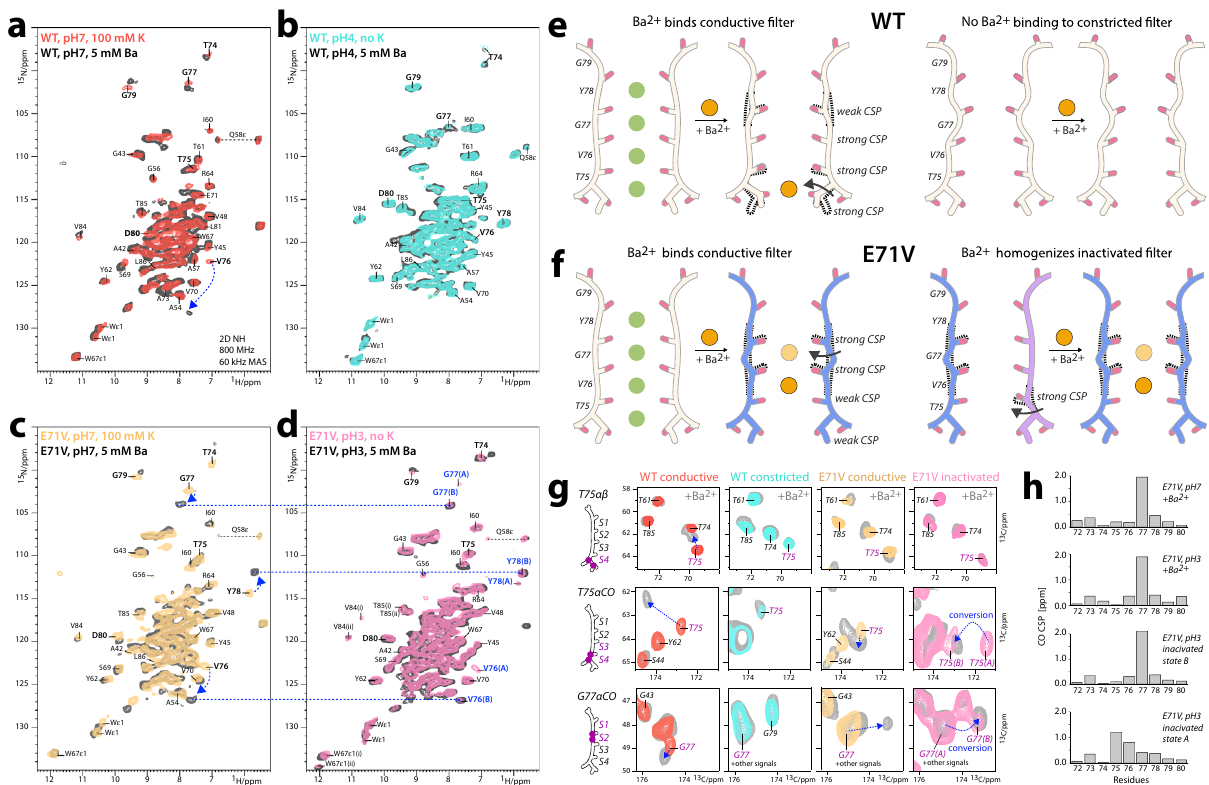
Fig. 5 ssNMR barium-binding studies. 2D NH spectra of a closed-conductive WT KcsA (red), b open-inactivated WT (cyan), c closed-conductive E71V KcsA (yellow), and d open-inactivated E71V (pink). Superimposed (in gray) are 2D NH spectra after equilibration with 5 mM Ba 2 + solution of the same pH as the original sample. Major Ba 2 + -caused signal changes are indicated by arrows. The two conformations A and B of the E71V fi lter under inactivating conditions are highlighted by blue labels. Blue lines show that Ba 2 + binds the E71V fi lter with a conformation similar to conformation B at neutral and